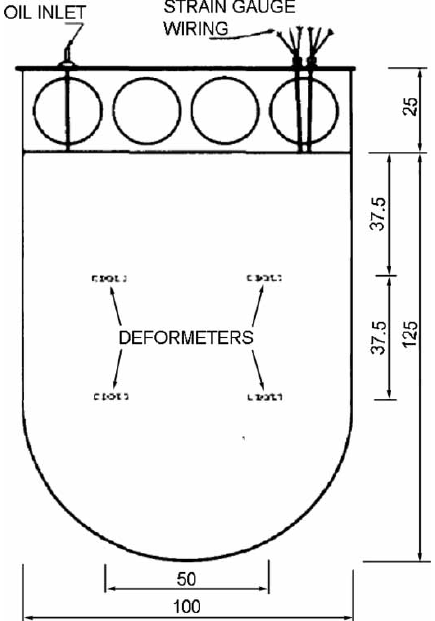
Fig. 3. Large flat jack (ISRM